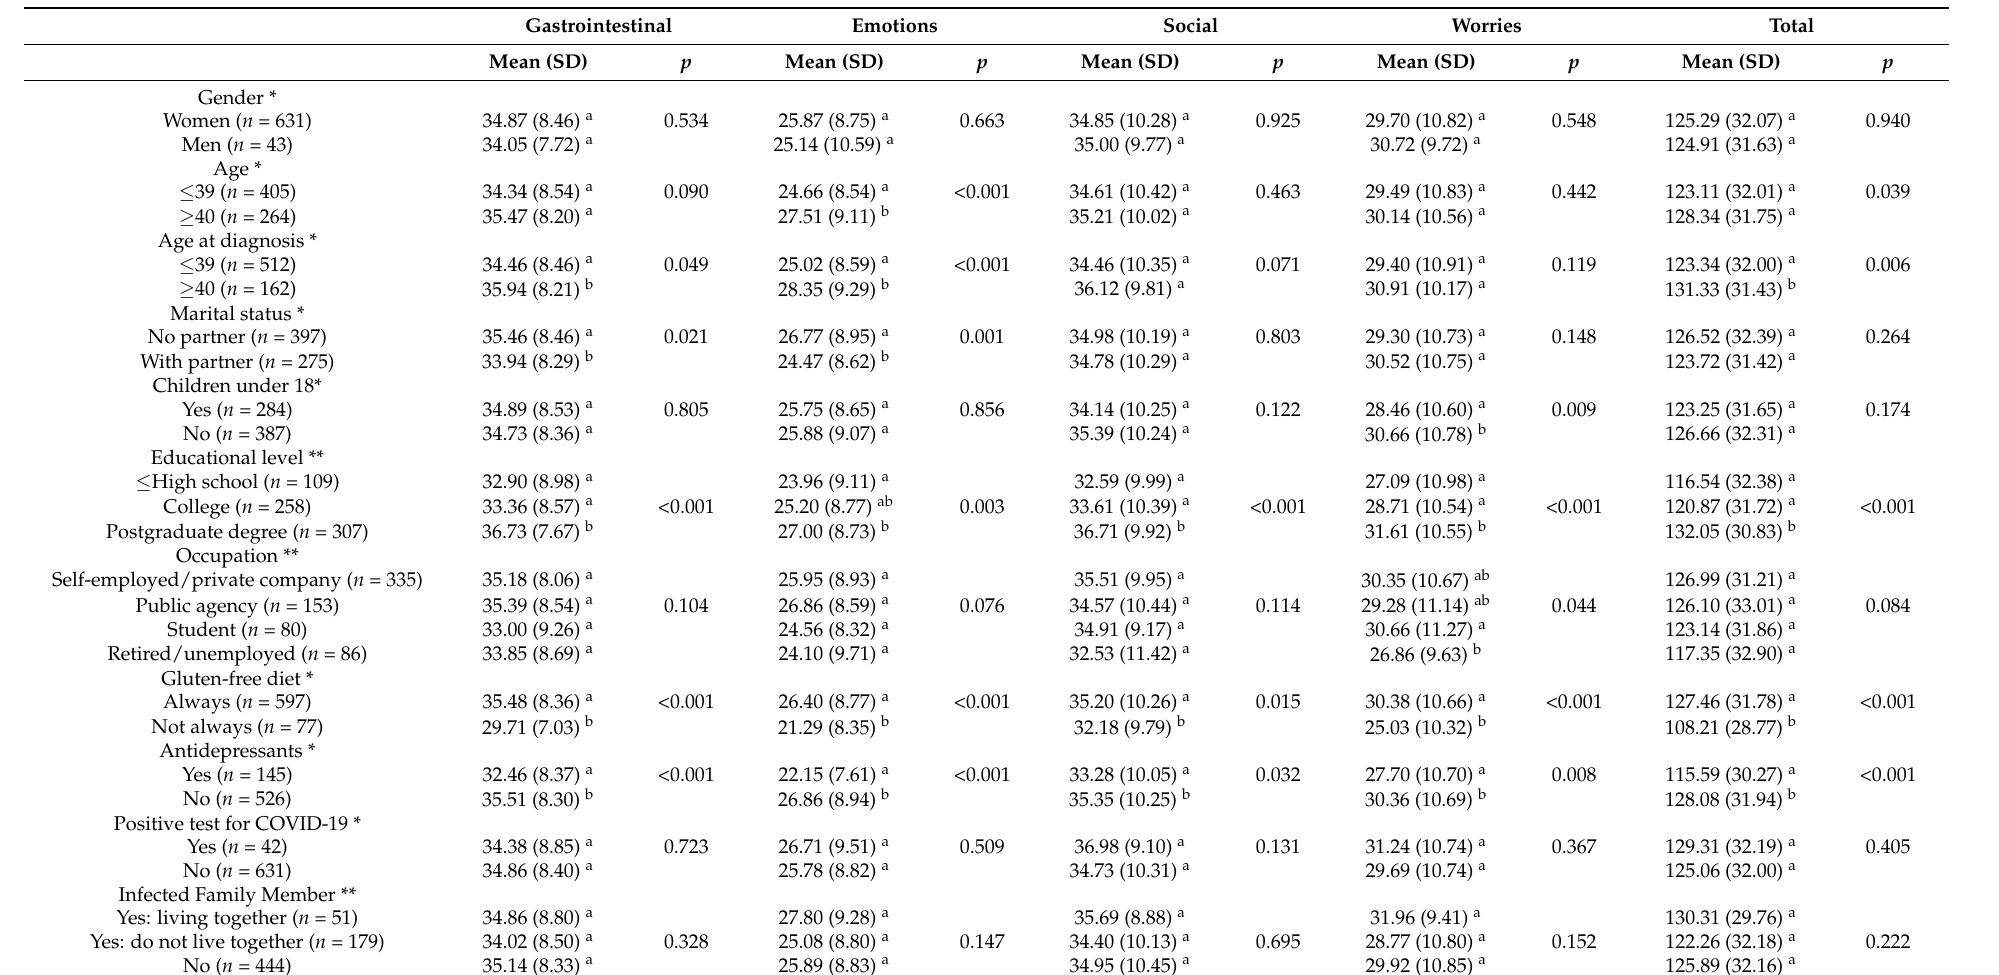
Table 2. CDQ sub-scores subcategorized by sociodemographic data ( n =